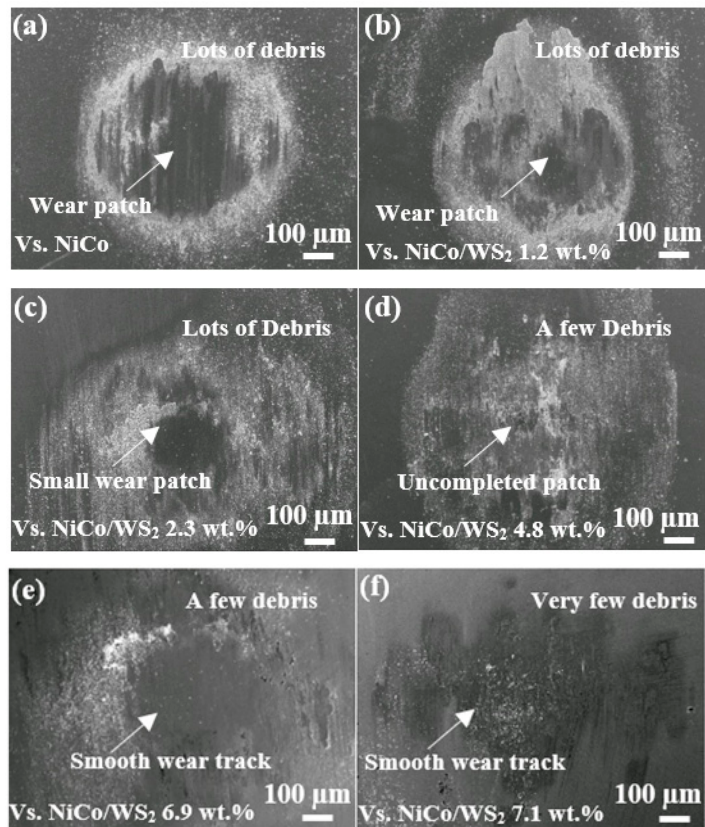
Figure 9. SEM images of counter balls after friction tests against ( a ) Ni–Co coating and Ni–Co/WS 2 coatings with different WS 2 contents: ( b ) 1.2 wt.%, ( c ) 2.3 wt.%, ( d ) 4.8 wt.%, ( e ) 6.7 wt.% and ( f ) 7.1 wt.%.